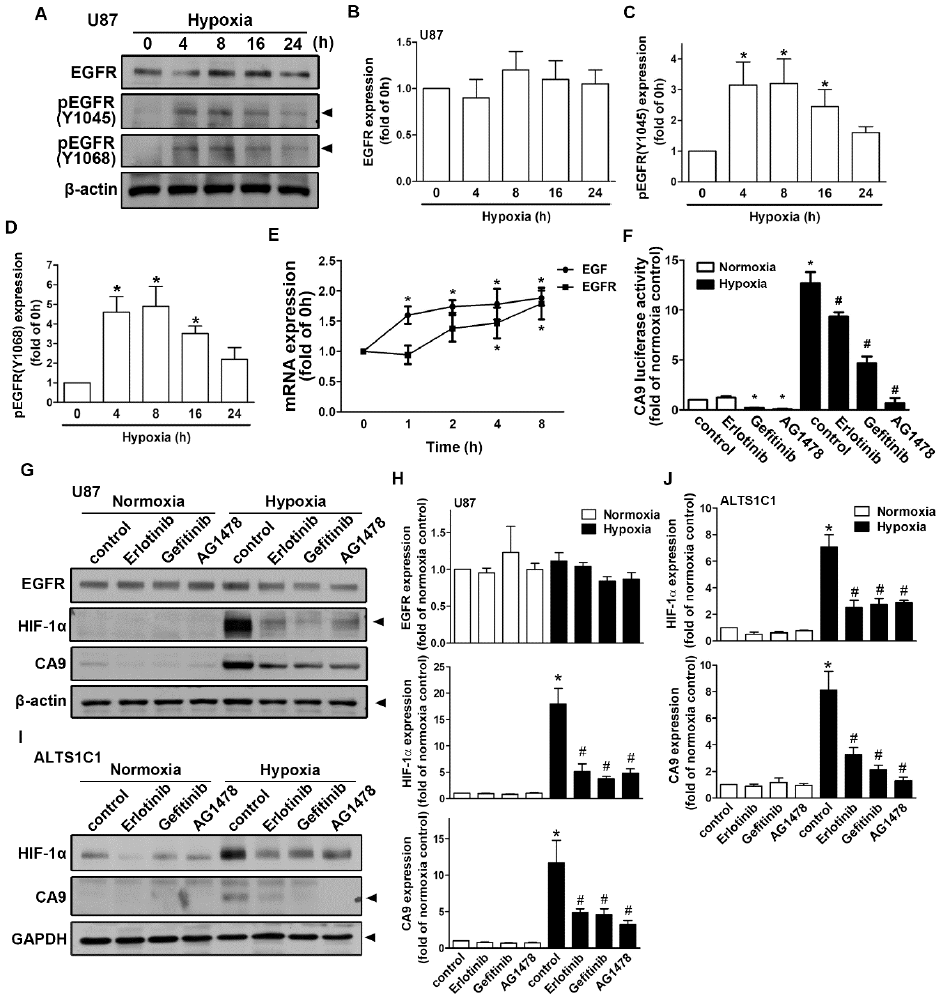
Figure 6. The activation of epidermal growth factor receptor (EGFR) is involved in the hypoxia-induced HIF- 1α and CAIX expression in GBM. ( A ) U87 cells were exposed to hypoxic conditions (1% oxygen (O 2 )) for the indicated time periods (4, 8, 16, or 24 h), and phosphorylated EGFR (Tyr1045 and Tyr1068) and EGFR expressions were determined by Western blot using whole cell lysates. The quantitative results are shown in a bar graph ( B – D ). ( E ) U87 cells were exposed to hypoxic conditions